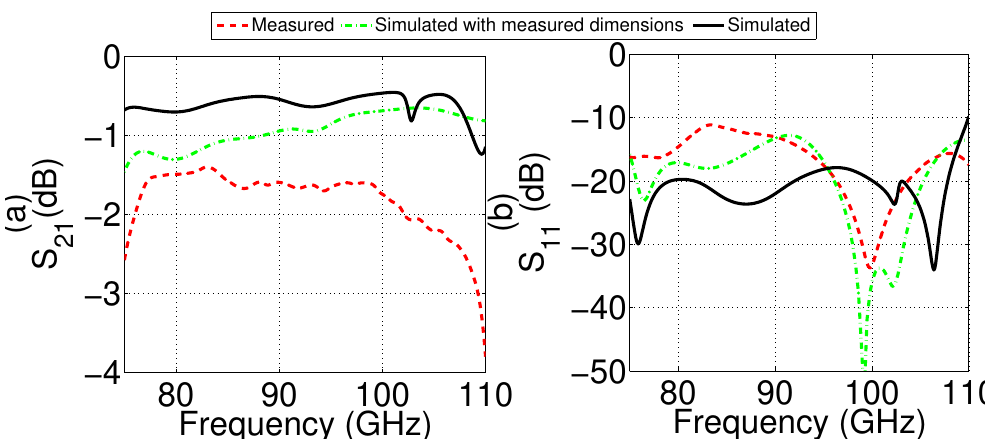
Figure 11. Comparison between predicted response (black solid line) and simulated transition taking into account the fabricated value (green dashed-point line) and measured (red dashed line) back-to-back configuration of the first transition model prototype (Figure 1a): ( left ) insertion loss and ( right ) return loss. Nevertheless, the simulated insertion loss was lower than 1 dB and the mean value was 0.6 dB.